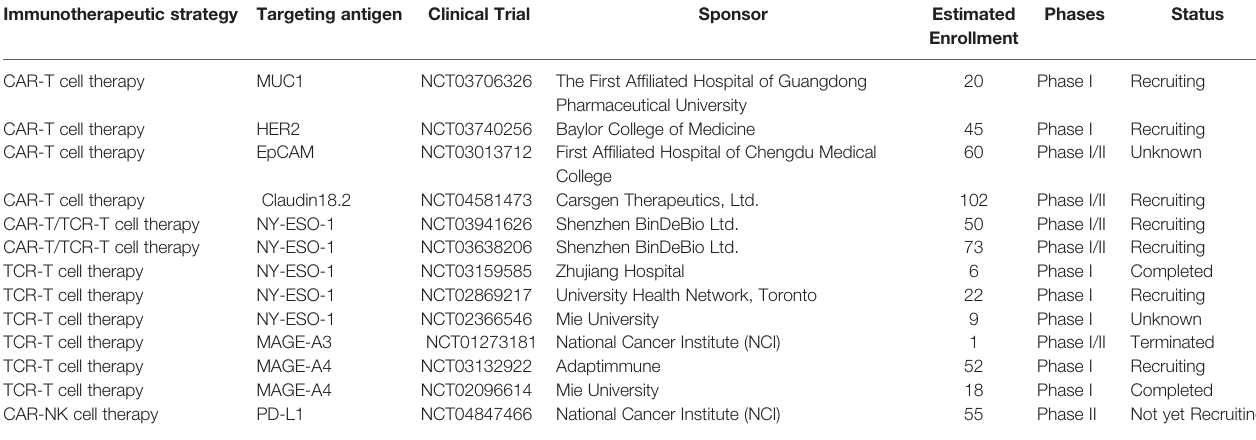
TABLE 1 | Summary of ongoing clinical trials of gene-modi fi ed T-cell therapy in the treatment of esophageal cancer. Immunotherapeutic strategy Targeting